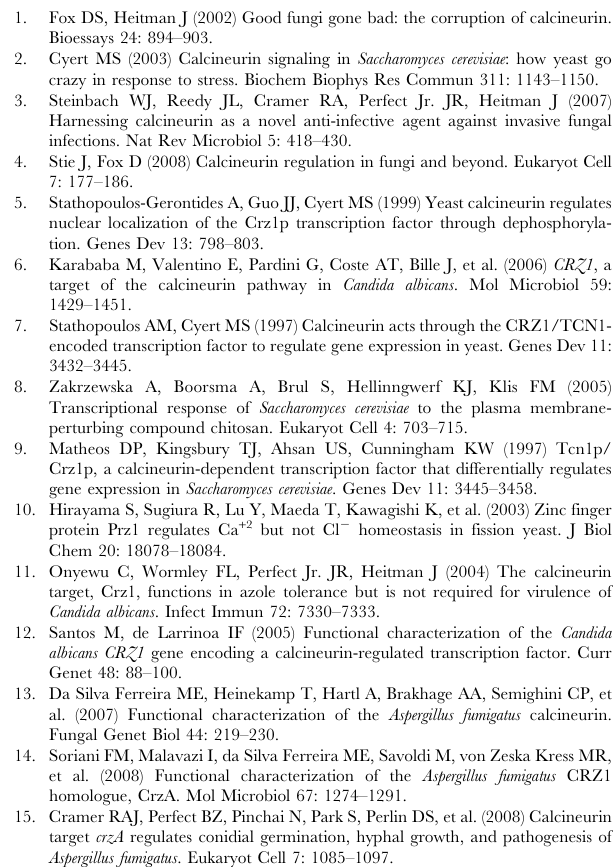
Figure S4 Histological analysis of alveolar lavages after infection with the A. fumigatus wild type, D calA , and D crzA strains. Germlings and host cells were detected by using Grocotts methenamine silver and haematoxylin and eosin staining, respectively. Bars, 100 m m. (PPTX) Figure S5 A. fumigatus D pmcB virulence studies in neutropenic mice. Comparative analysis of wild type and D pmcB strains in a neutropenic murine model of pulmonary aspergillosis. A group of 10 mice per strain was infected intranasally with 20 m l suspension of conidiospores at a dose of 2.0–5.0 6 10 4 . (PPTX) Figure S6 (A) Growth phenotype of the D pmcA::pmcA + strain grown on YAG + CaCl 2 500 mM. (B) PCR of the pmcA open reading frame. (C) PCR of the pmcB open reading frame. (PPT) Table S1 List of primers and probes used in this